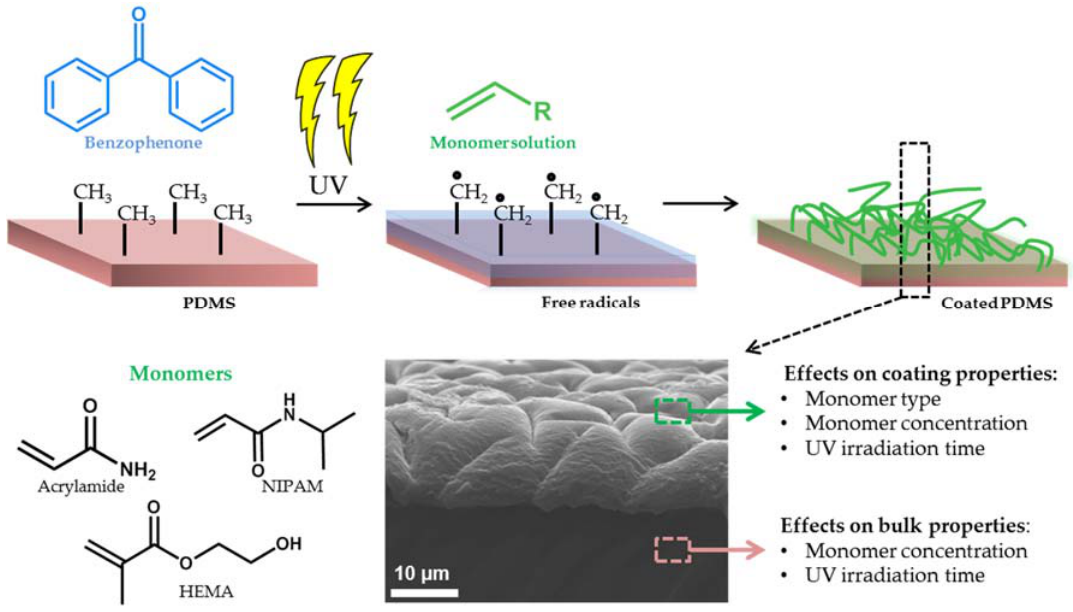
Figure 1. Schematic illustration of UV ‐ mediated free radical polymerization onto a polydimethylsiloxane PDMS surface. The molecular structures used, a representative image for a hydrogel coating, and the main parameters that affect either the coating or the bulk properties are shown.